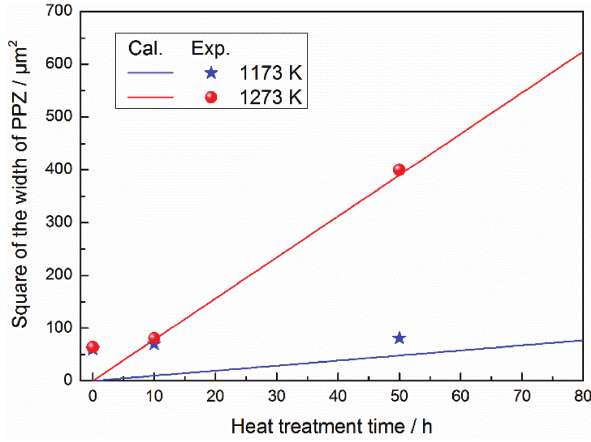
Figure 12: Comparison of the measured width of the PPZ with the theoretical